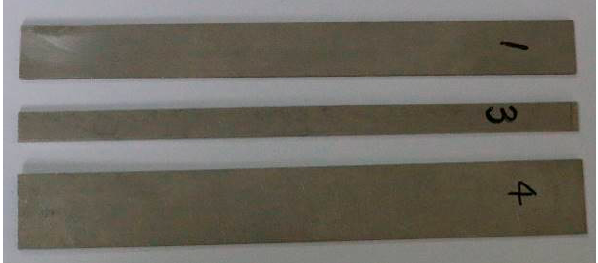
Figure 11. Waveguide bars named by No. 1, No. 3 and No. 4 (the width of No. 1 is 15 mm, No. 3 is 7 mm, and No. 4 is 20 mm).